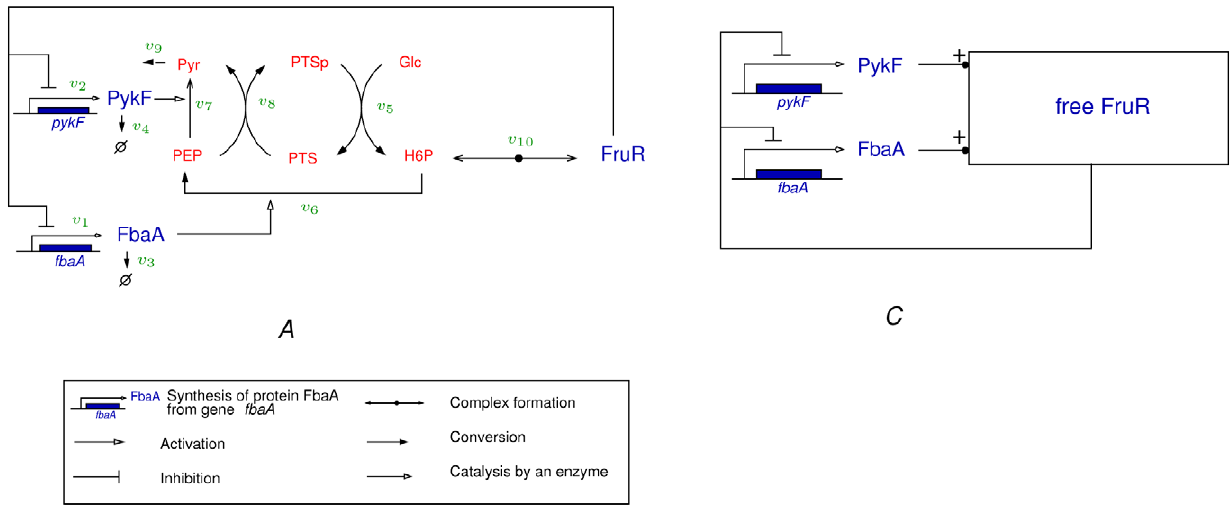
Figure 3. Simplified glycolysis model, adapted from [ 30 ] , including the genetic regulation of enzyme expression by FruR. A : Network of biochemical reactions. The conversion of a generic hexose-6-phosphate H6P to PEP is schematized as a single reaction, with FbaA being assumed representative of all glycolytic enzymes. The network also includes a simplified description of the PTS, including the phosphorylated and non- phosphorylated form of its enzymes (represented by PTSp and PTS, respectively). The total concentration of the PTS enzymes is assumed constant. FruR is inactivated when bound to fructose-6-phosphate, here represented by H6P. The total (bound and unbound) FruR concentration is assumed constant in this example. The reactions correspond to protein synthesis ( v 1 , v 2 ), protein degradation ( v 3 , v 4 ), enzymatic reactions ( v 5 , ... , v 9 ), and complex formation ( v 10 ). Proteins are shown in red, metabolites in blue, and reactions in green. B : Kinetic model of the network in the form of Eq. 3 and 4, separating the slow (protein synthesis and degradation) from the fast processes (enzymatic reactions and complex formation). The corresponding slow variables are the total enzyme concentrations ( x PykF , x FbaA ), while the fast variables are the metabolite concentrations ( x Glc , x H 6 P , x PEP , x Pyr ), the concentration of FruR protein in its free form ( x FruR : free ), and the phosphorylated PTS enzyme ( x PTSp ). C : Complete network of direct and indirect gene regulatory interactions, with unequivocal signs for the influences of the enzymes on the concentration of free FruR. The interactions are derived from the Jacobian matrix of the slow system (for the detailed analysis of the network, see Text